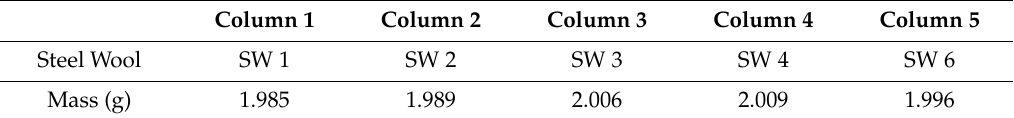
Table 2. The selected metallic iron (Fe 0 ) SW specimens for investigation in column studies with 25 mg L − 1 fluoride solution. An amount of 2.0 g of each sample was cut into small pieces and placed in the reactive zone of its respective